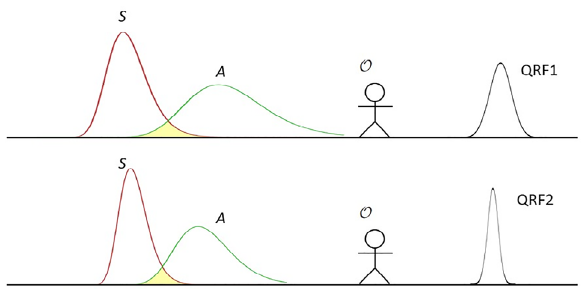
Figure 1. Schematic illustration of the entities for the terminologies. The overlapping of the measured system S and apparatus A represents there is interaction in a measurement event. The relational properties between S and A must be described relative a QRF. There can be multiple QRFs. Selecting a different QRF, O can have a different description of the relational properties in a quantum measurement